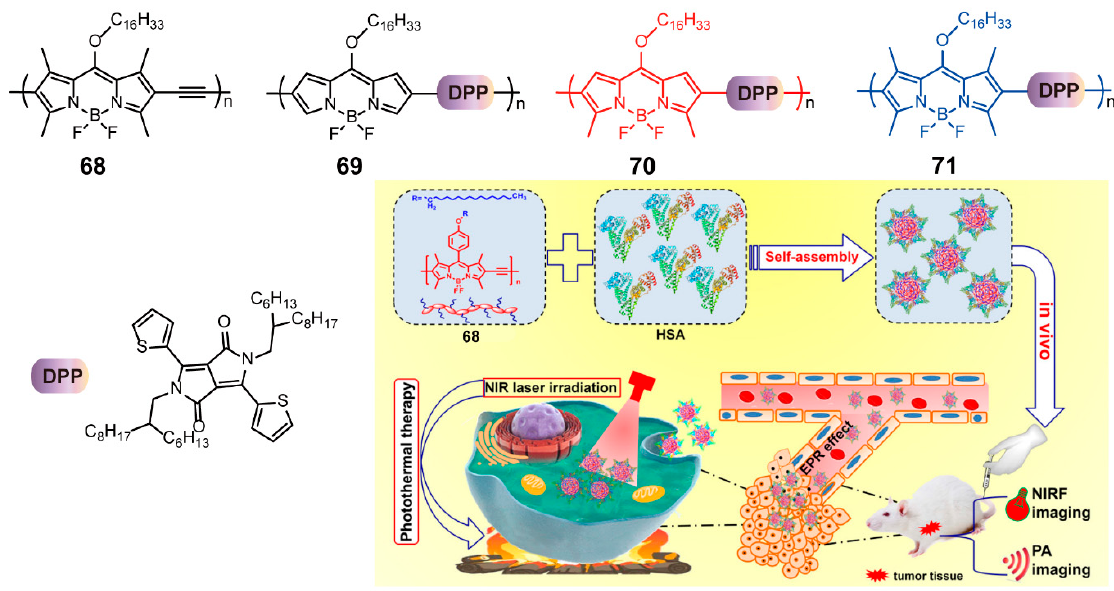
Figure 23. Chemical structures of polymers 68–71 and schematic illustration of fabrication self-assembly procedures and applications of NPs (Reproduced with permission from Reference [90]. Copyright @ 2019 ACS publication).